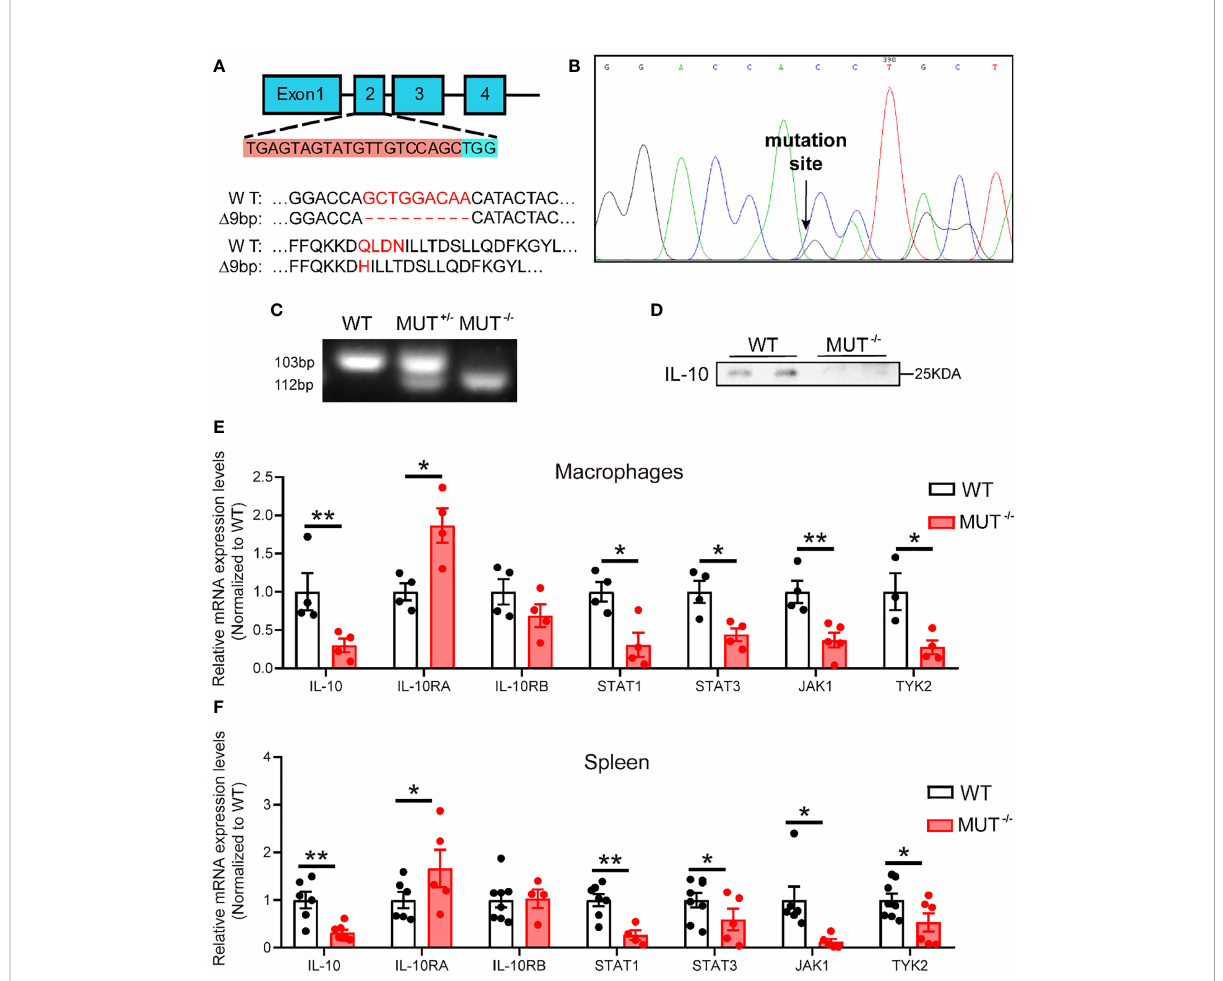
FIGURE 1 Generation and characterization of IL-10 mutant hamster model using CRISPR/Cas9 gene editing system. (A) Schematic of targeting the exon 2 of hamster IL-10 gene. The sgRNA and PAM sequences (TGG) are highlighted with orange and blue background, respectively. Mismatched nucleotide bases and amino acids are marked in red. (B) Sequencing of CRISPR/Cas9-edited IL-10 locus in Founder. Double peaks appeared at the mutation site. (C) Genotyping of F2 generations from wild type (WT), heterozygous (IL-10 WT/MUT ), and homozygous (IL-10 MUT/MUT ) IL-10 mutant hamsters. (D) Representative Western blot of plasma IL-10 from 3-month-old male WT and IL-10 MUT/MUT hamsters on chow diet. (E and F) mRNA expression levels of genes involved in IL-10 signaling pathway in macrophages (E) and spleen (F) were determined by real-time PCR (n=4~7/group). All data were expressed as means ± SEM, *p<0.05;